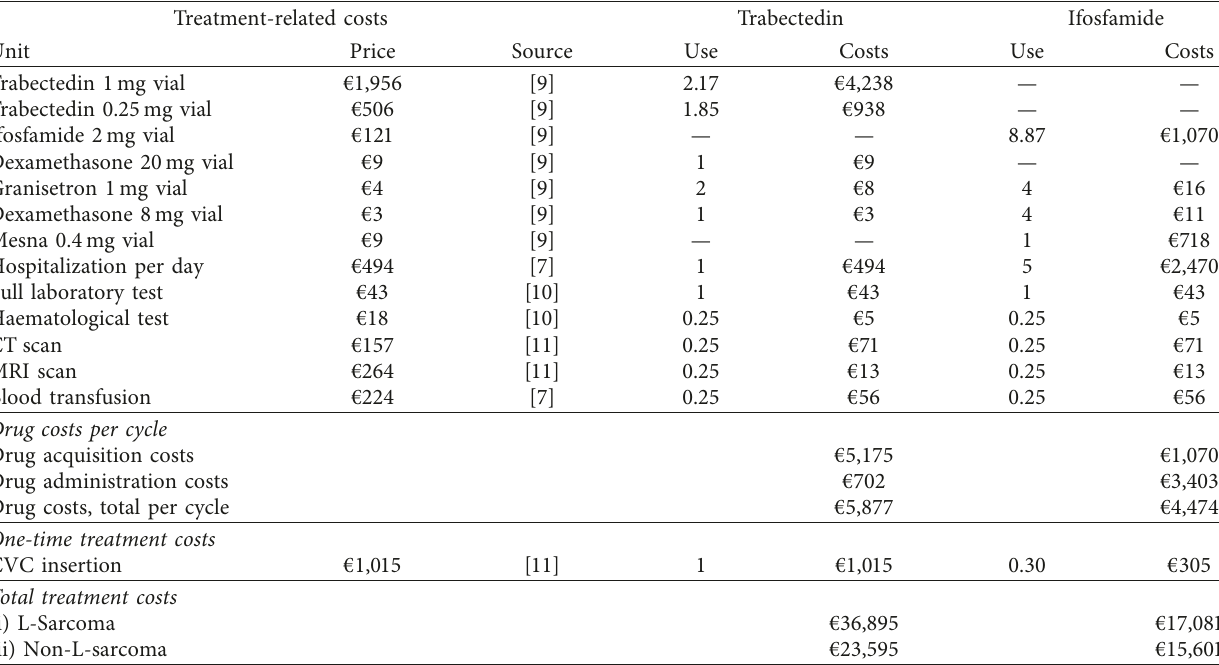
Table 3: Treatment-related costs of trabectedin and ifosfamide, for the average number of treatment cycles (see Table 2). Treatment-related costs